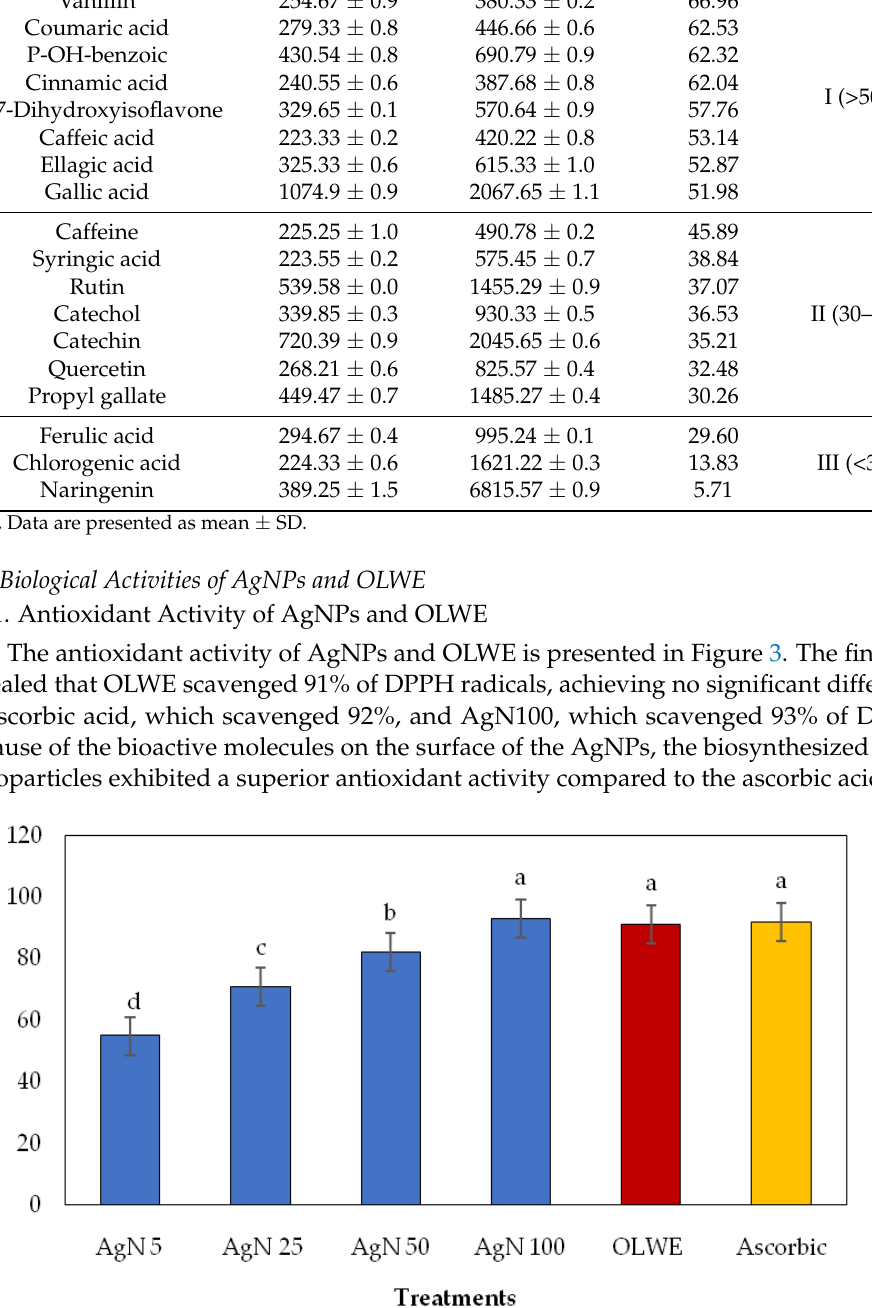
Table 1. Phenolic compound profile of the AgNPs and OLWE.